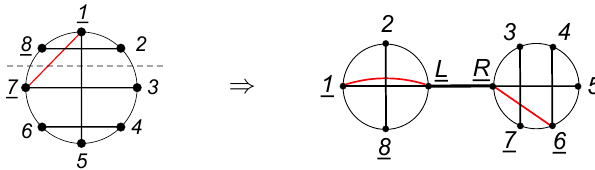
Figure 11 . Ladder diagram, A ( I 8 : 15 , 28 , 37 , 46) , and its factorization